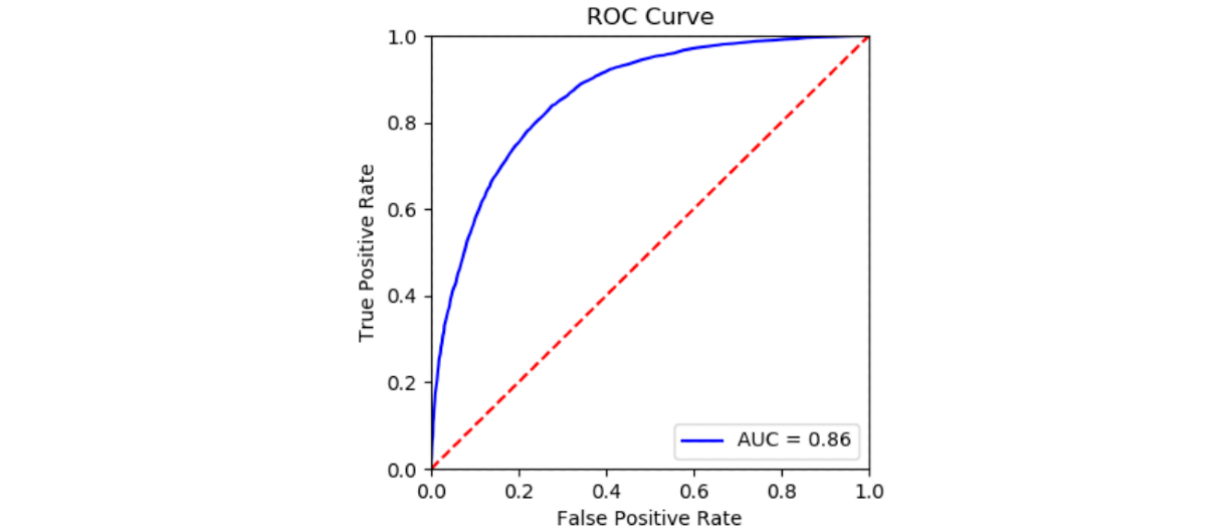
Figure 2. Scream classification performance on the AudioSet data. AUC: area under the curve; ROC: receiver operating